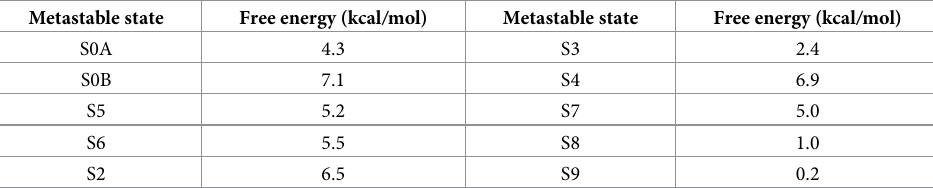
Table 1. The free energy of metastable